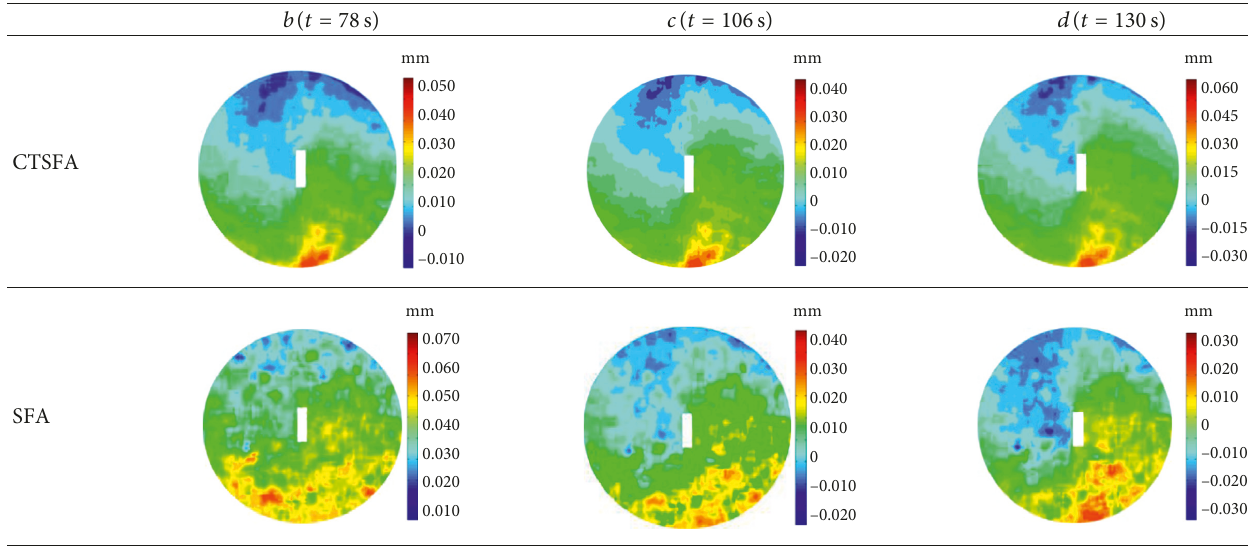
Table 1: u field of CTSFA and SFA at different